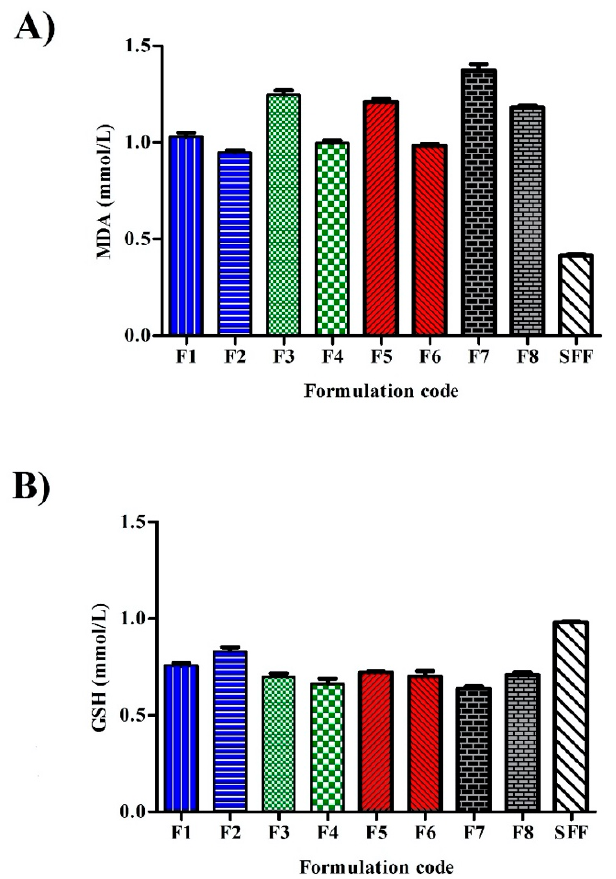
Figure 9. Intracellular production of ( A ) malondialdehyde (MDA) and ( B ) reduced glutathione (GSH) after exposure to SFF and different stabilizers containing formulations after incubation with 50 μ g/mL after 24 h ( n = 3).